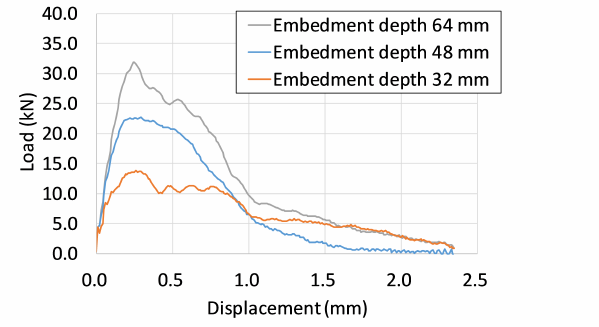
Figure 16. Effect of embedment depths on the fracture pattern.